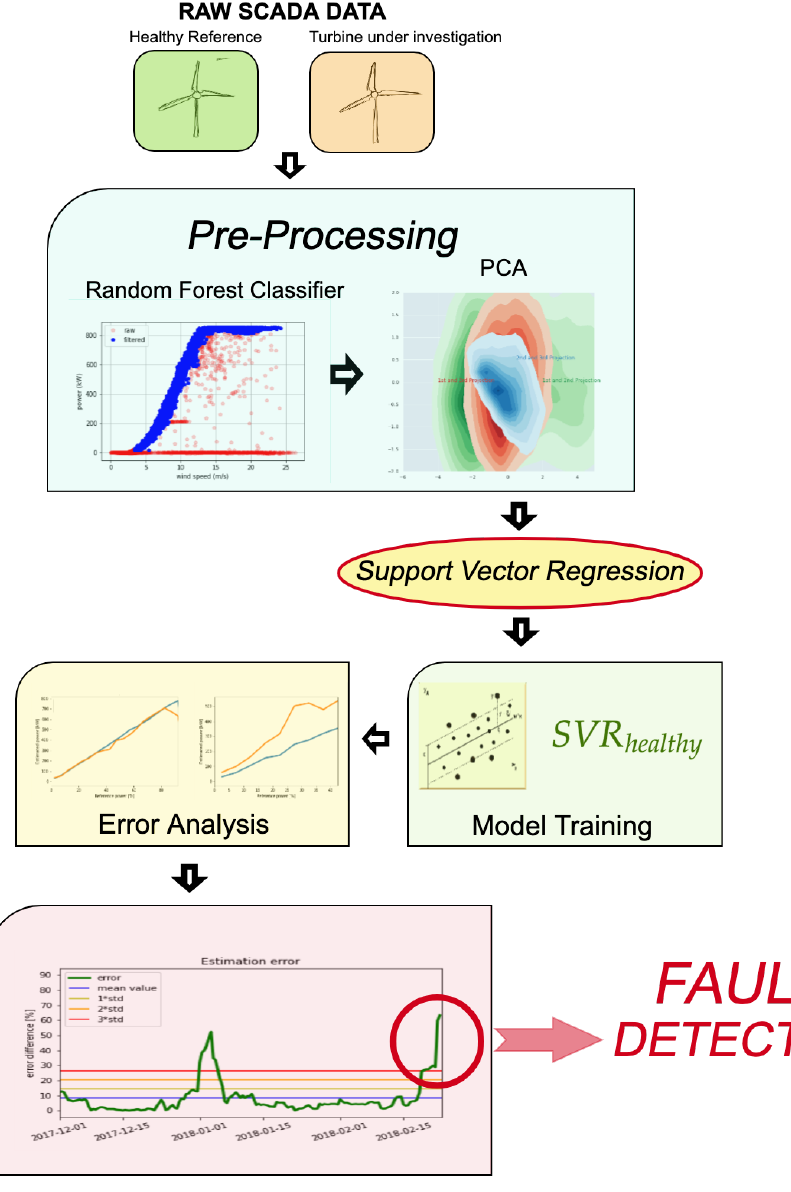
Figure 2. Schematic of the overall process for fault